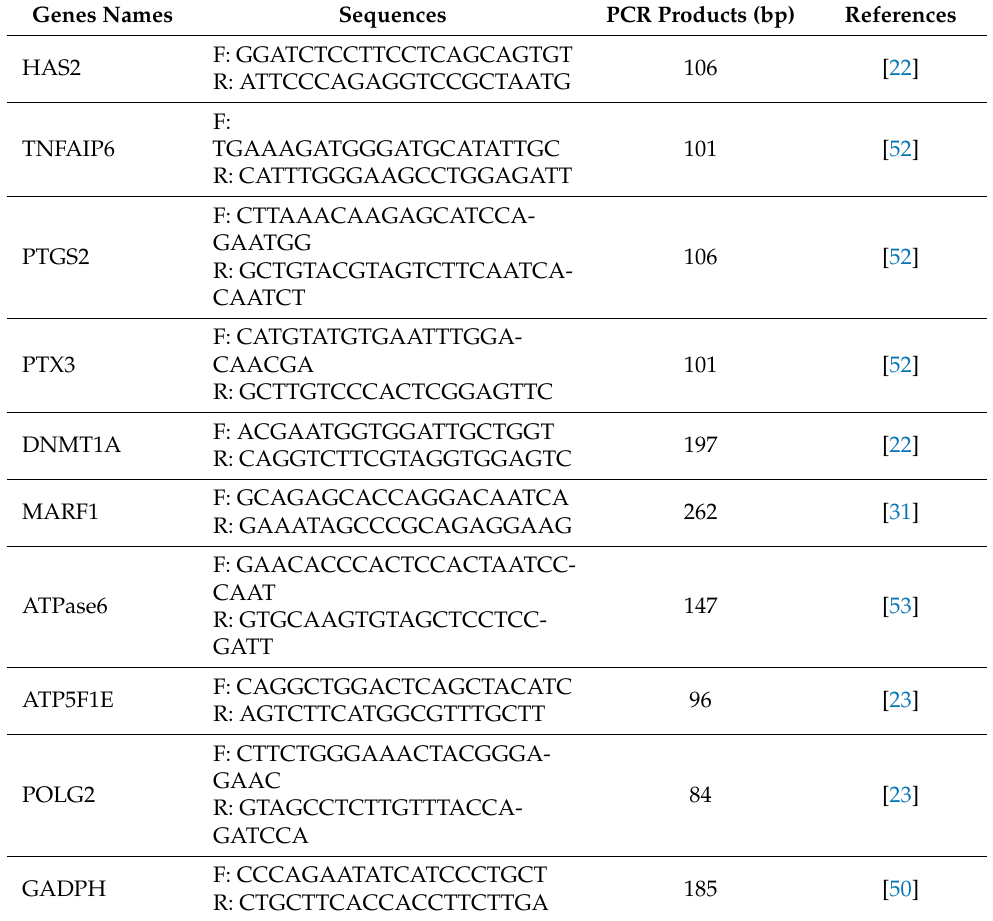
Table 1. List of primer